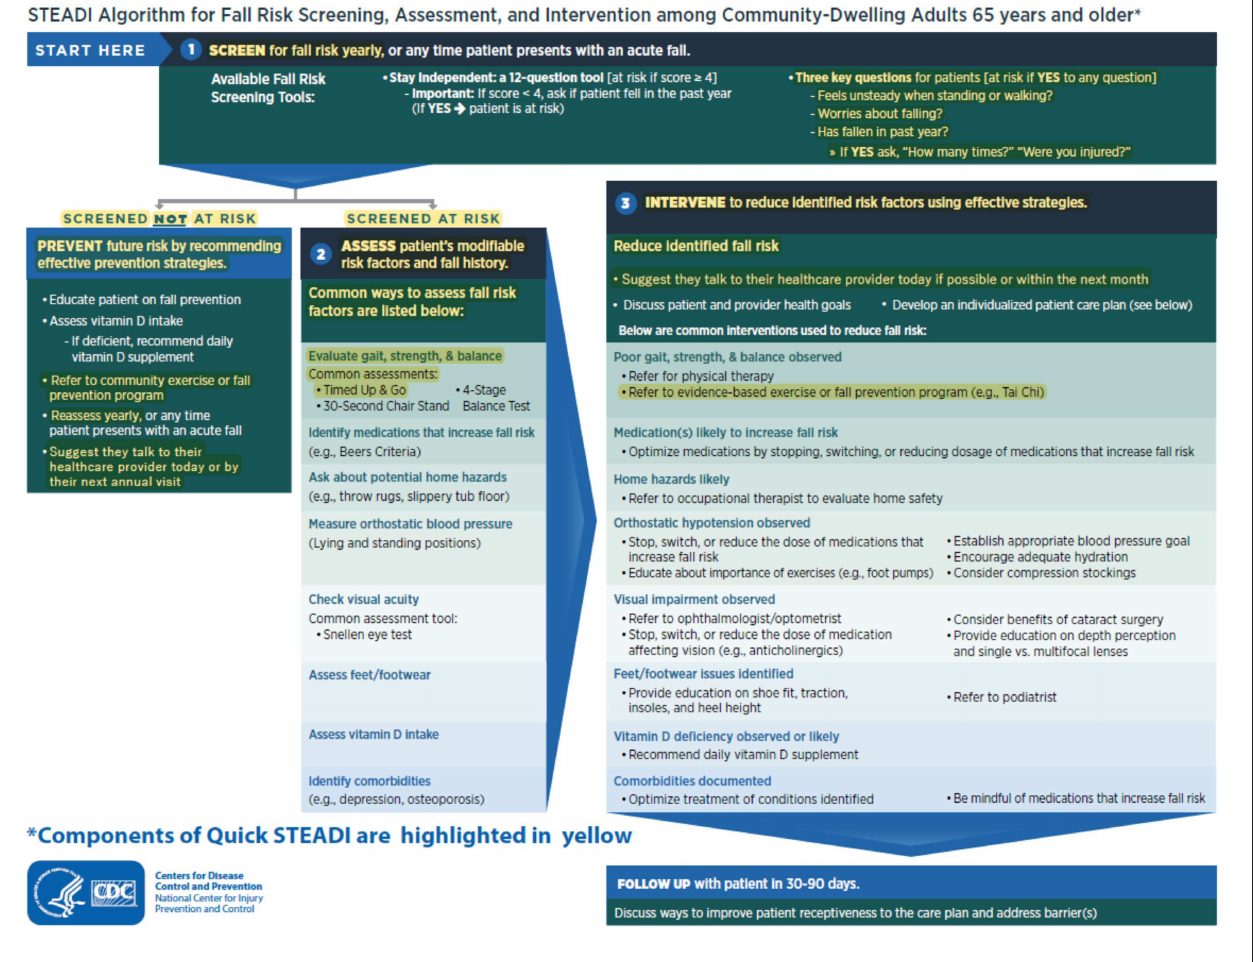
FIGURE 1 | Two-level CDC STEADI algorithm